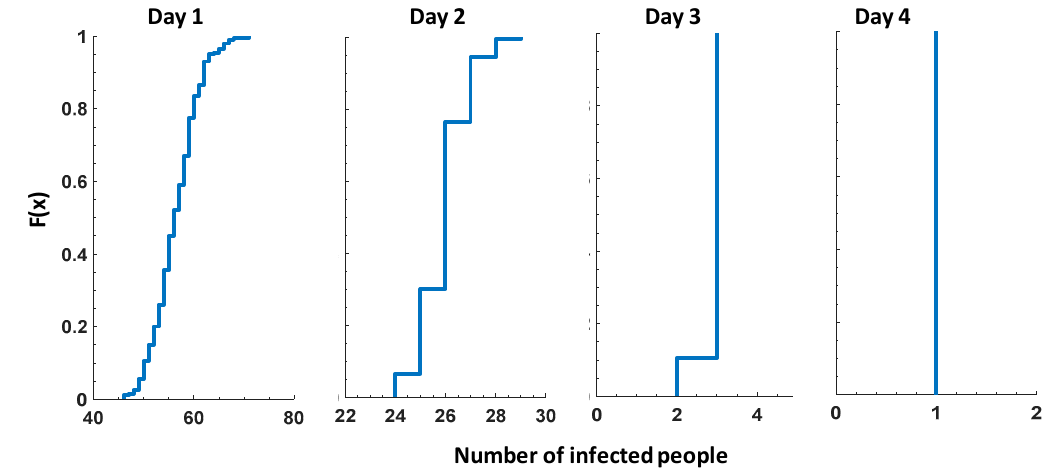
Figure 8. Number of infected people corresponding to median infection risk for Days 1–4 for the scenario of 1 h of PDCs with daily consumption patterns; C out = 560 oocysts / L; 200 Monte Carlo simulations (consumption events) every day.